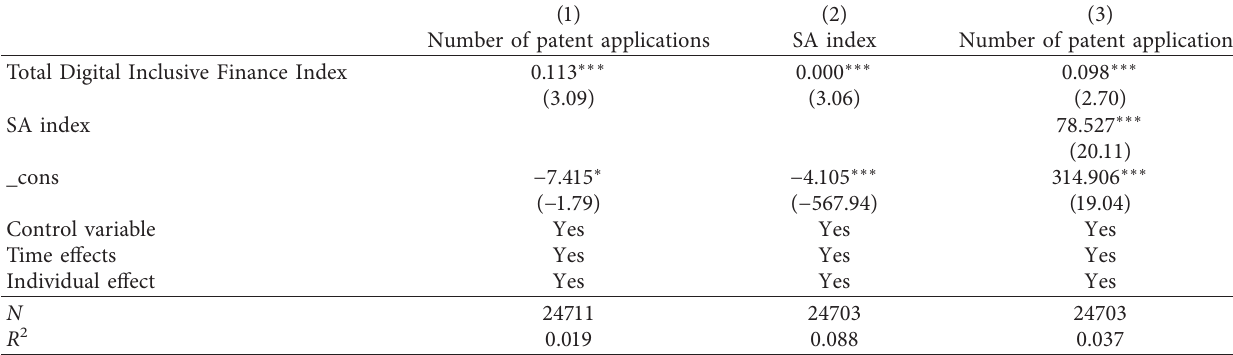
Table 5: Intermediary mechanisms, financing constraints.